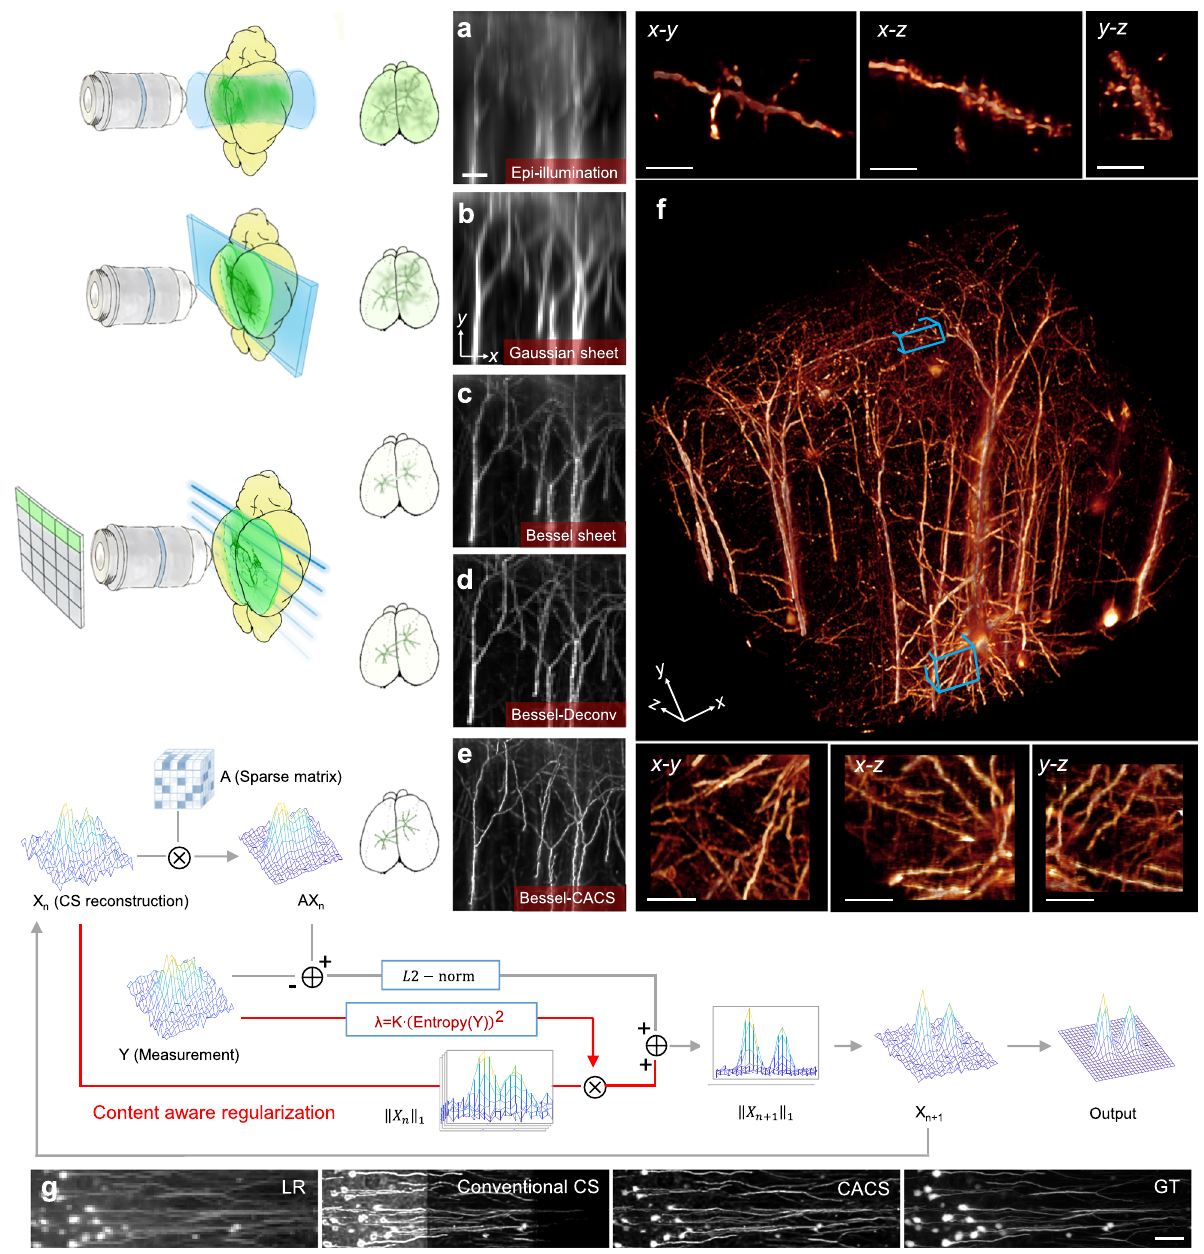
Fig. 1 CACS Bessel plane illumination microscopy and other imaging modes. a Epi-illumination mode (left), and maximum-intensity-projection (MIP) in the y-z plane from a 3D image stack of a cleared transgenic mouse brain tissue with GFP labelled to the neurons (right, ×3.2/0.28 objective). b Gaussian sheet mode (left) showing plane illumination at selective depth of brain, and y-z plane MIP from the same sample (right, 0.02 NA illumination + ×3.2/0.28 detection). c – e Raw, Deconvolution and CACS modes under our synchronized Bessel plane illumination geometry (0.14 NA illumination + ×3.2/0.28 detection), showing much sharper optical sectioning ( c, d left) and how CACS computation being further applied to super-resolve the image ( e left). The y-z plane MIPs by each mode are accordingly shown in right columns. Scale bar, 20 μ m. f Volume rendering of GFP-labelled neurons in a cleared mouse cortex tissue by ×3.2 Bessel-CACS mode. Insets: MIPs along orthogonal axes of the cubical volume of interest (blue boxes). Scale bar, 10 μ m. g Comparison between raw LR image, conventional CS recovery with constant parameters, CACS recovery with adaptive parameters, and ×12.6 ground- truth image. Each experiment was repeated three times independently with similar results. Scale bar, 100 μ